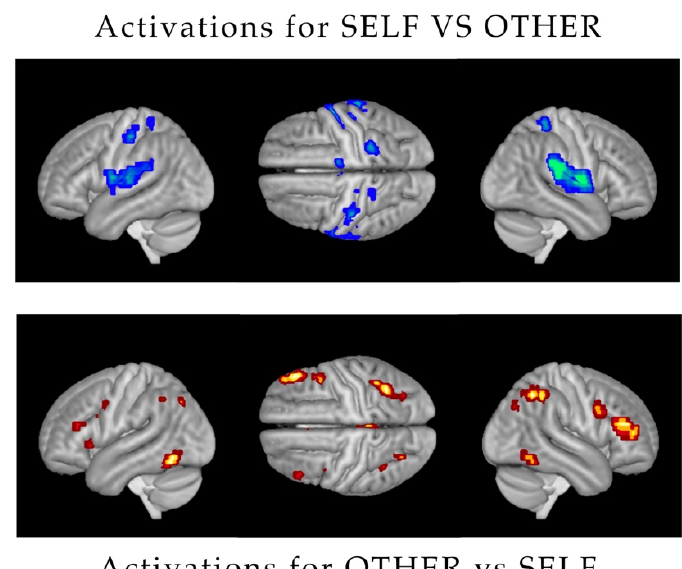
Figure 3. Various Activations: ( above ) Activation of the dorso-lateral fronto-parietal cortex and occipital-temporal cortex for the main effect SELF vs. OTHERS and ( below ) bilateral sensor motor cortices, the superior temporal gyrus, and the insula for OTHER vs. SELF.